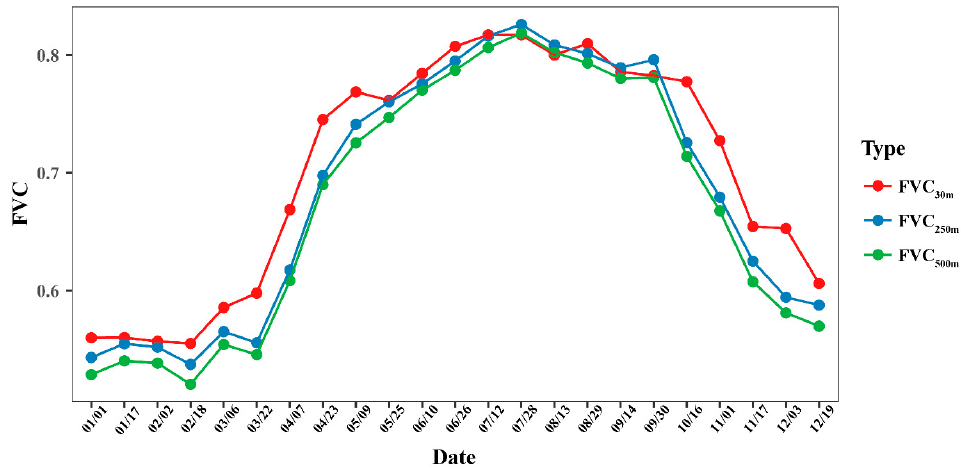
Figure 6. Annual temporal profile of the mean FVC from the three spatial resolutions images. Moreover, the time-series variations in the mean FVC levels from three spatial reso- lutions were extracted, as shown in Figure 7. The time-series values of each FVC 30m are generally higher than the values of each level of FVC 10m . The temporal profiles of FVC 30m , FVC 250m , and FVC 500m are the most similar when FVC 10m is 0.6~0.7 (Figure 7c). When FVC 10m is less than 0.6, the temporal profile of FVC 30m is lower than that of FVC 250m /FVC 500m , and the gap increases as FVC decreases (Figure 7a,b). On the contrary, when FVC 10m is higher than 0.7, the temporal profile of FVC 30m is higher than that of FVC 250m /FVC 500m , and the gap enlarges as FVC increases.